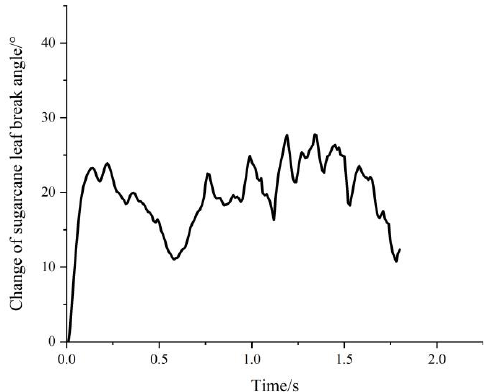
Figure 13. Change in the bending angle of the sugarcane leaf during the picking process.